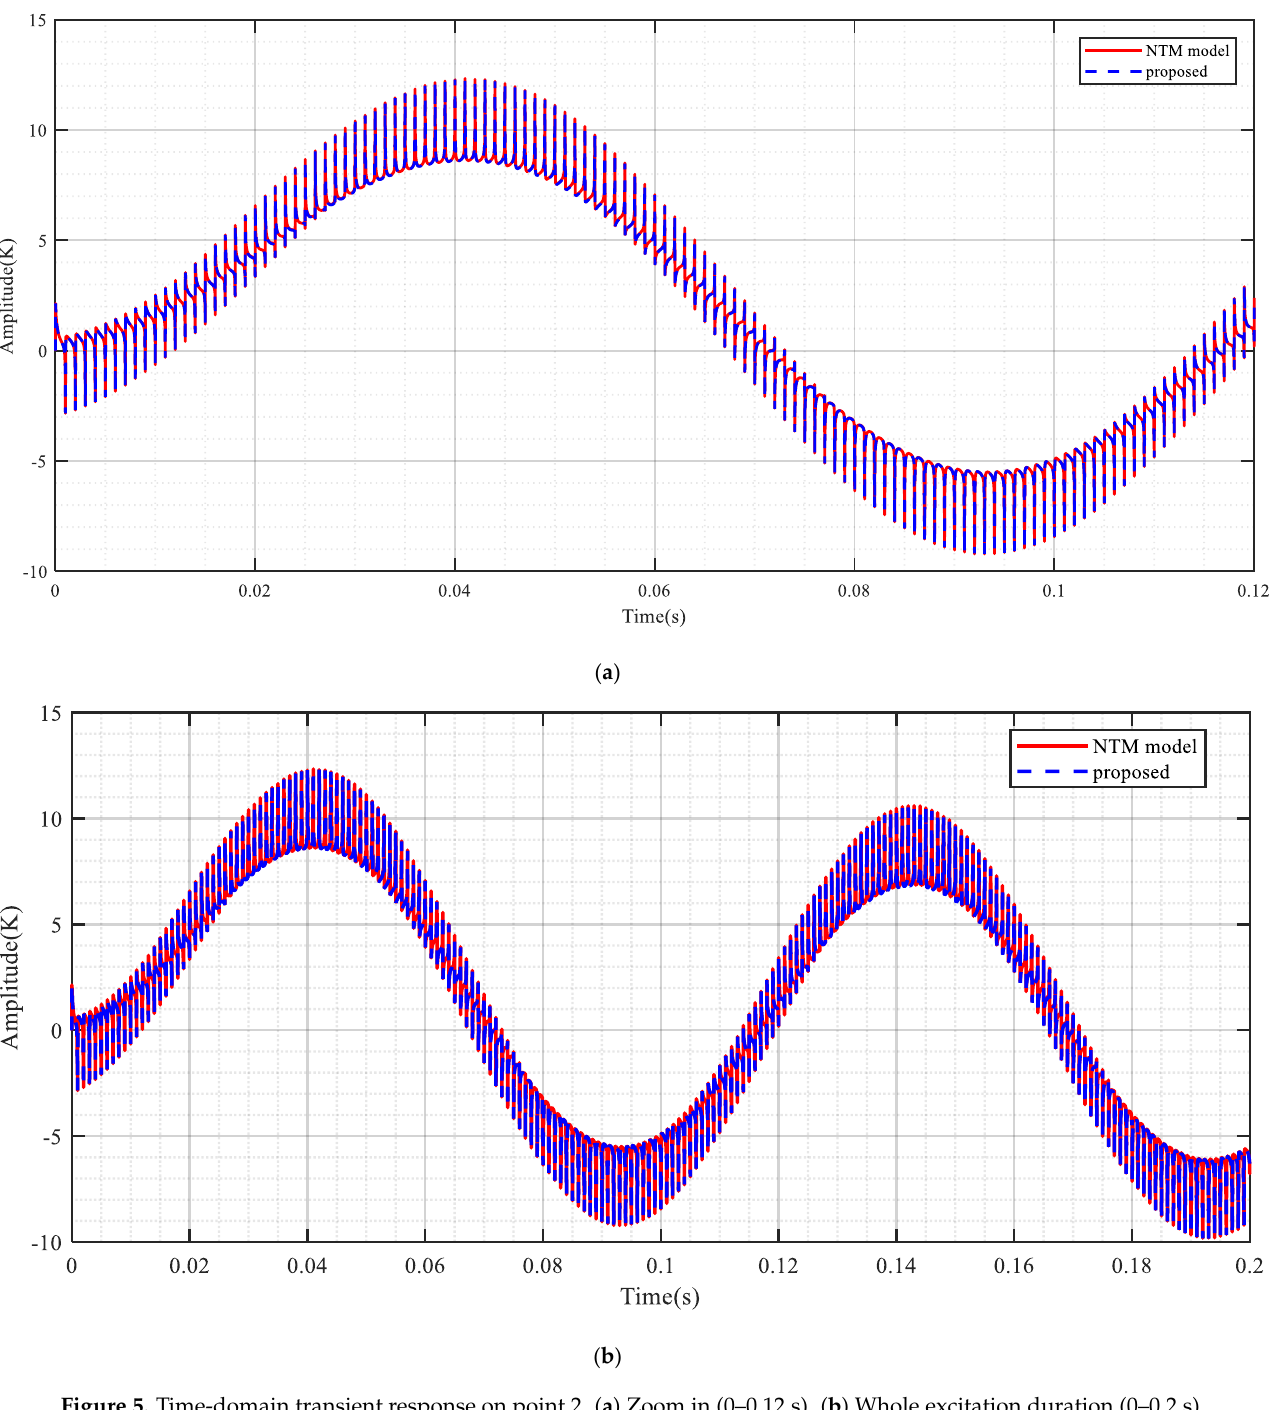
Figure 5. Time-domain transient response on point 2. ( a ) Zoom in (0 – 0.12 s). ( b ) Whole excitation duration (0 – 0.2 s).